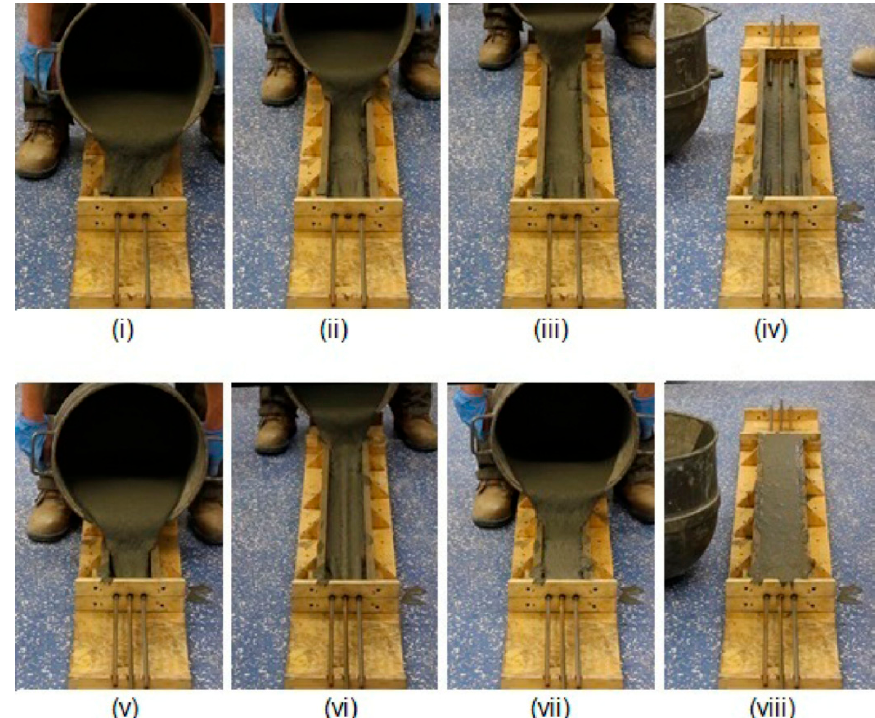
Figure 11. Casting sequence for parallel fiber orientation: ( i–iii ) UHPC is being poured back and forth from one end to the other to align the fibers; ( iv ) The pullout bar and the support bar are placed; ( v–vii ) UHPC is being poured back and forth from one end to the other to align the fibers; ( viii ) Pouring of UHPC is completed.